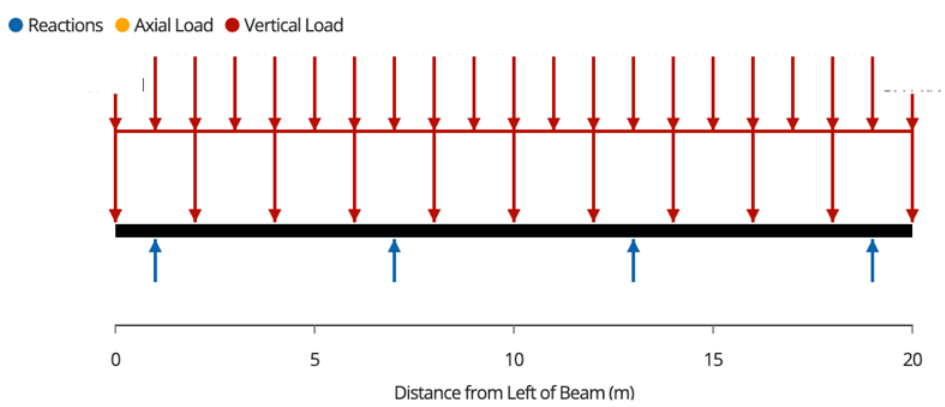
Figure A7. Double-span beam free-body diagram.